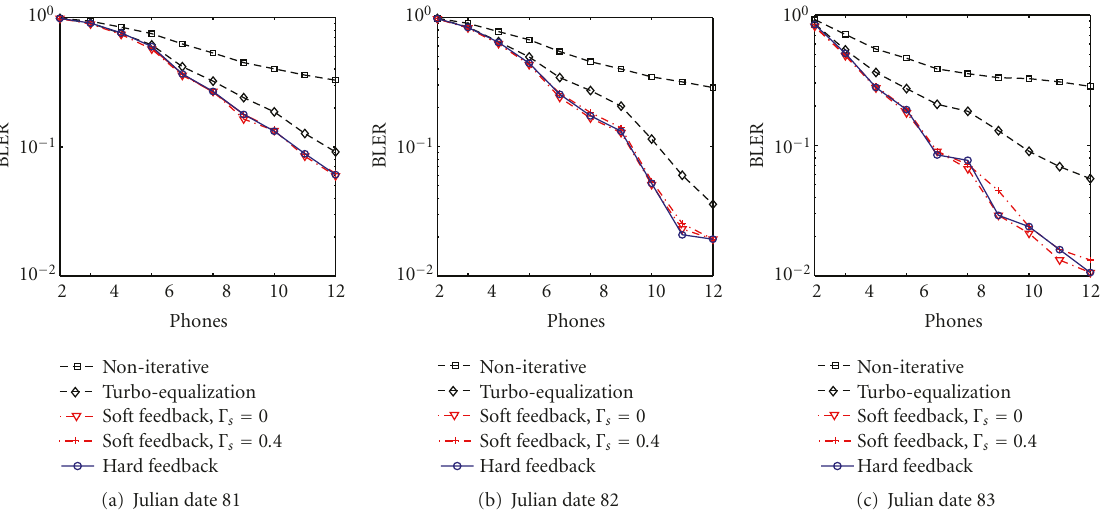
Figure 8: Experimental results from the RACE08 experiment on MIMO-OFDM with N t = 3 and